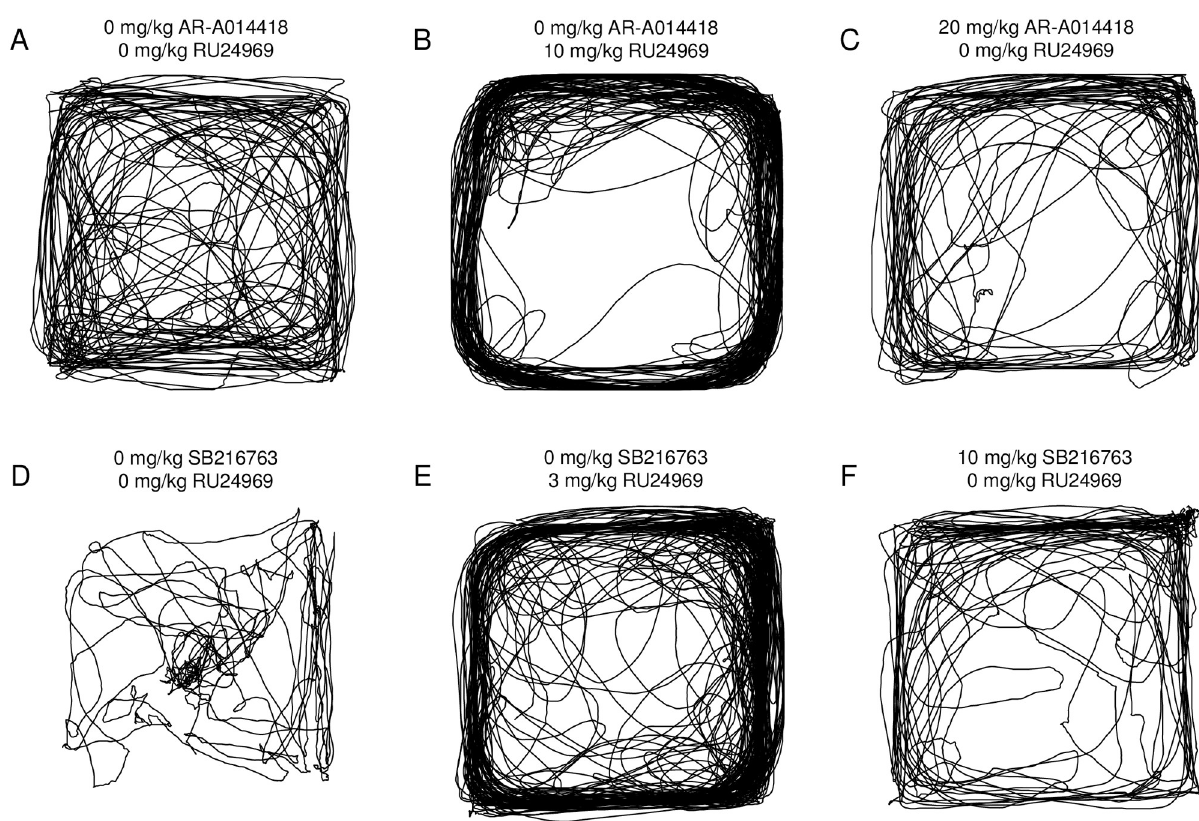
Fig 2. Both RU24969 and GSK-3 inhibitors reduce spatial d . Example traces of open field paths from mice in Experiment 4 (A-C) and Experiment 3 (D-F). RU24969-treated (B, E) and GSK-3 inhibitor-treated (C, F) mice have a similar pattern of activity characteristic of low spatial d , in contrast to mice treated only with vehicle (A,